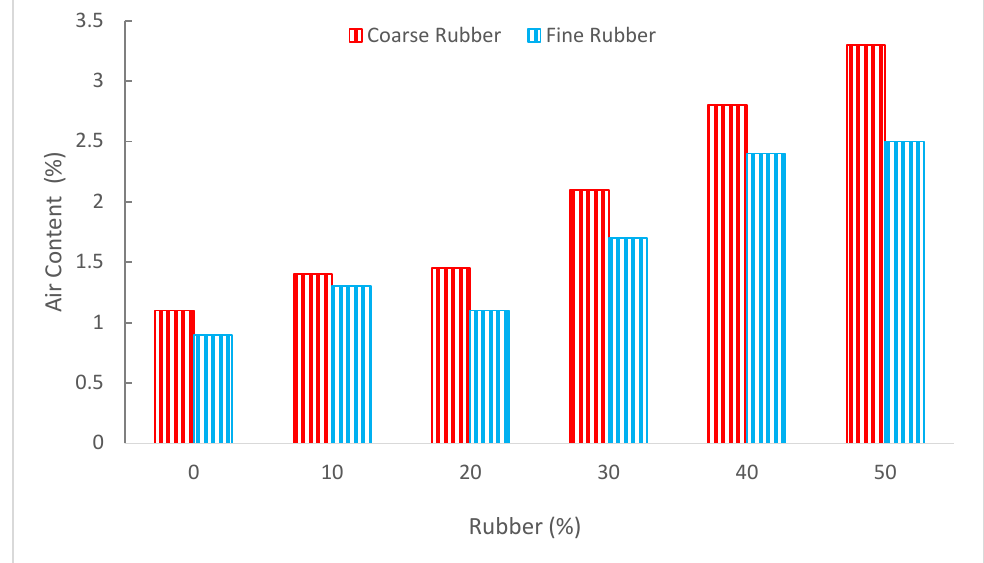
Figure 7. Air content: data source [55].